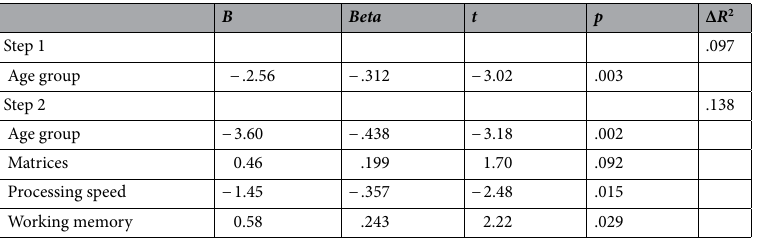
Table 6. Regression predicting eyes task performance. Δ R 2 represents the additional variance counted for by all the variables in a step. Regression statistics given with relevant variables at a step in the prediction equation. Age group was treated as a dichotomous variable (young vs. older adults) in the regression.